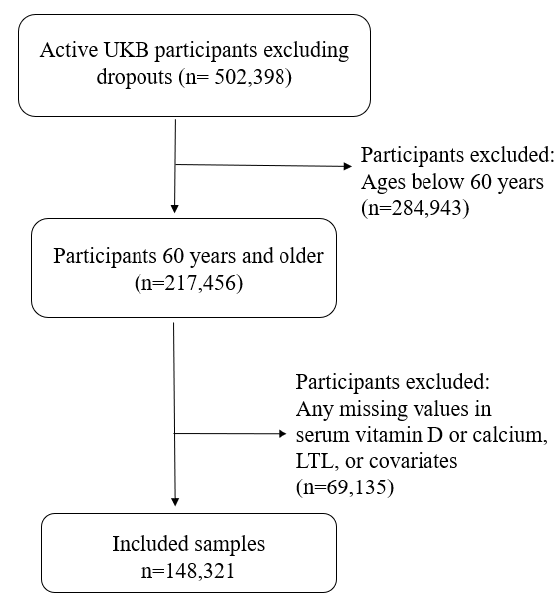
Figure 1. Flowchart of the final analytical Figure 2. Relationship of z ‐ transformed leukocyte telomere length versus z ‐ transformed vitamin D (curve plotted based on the generalized additive model including a cubic regression spline with shrinkage ‐ to ‐ zero). Table 3. Association between vitamin D and leukocyte telomere length, unadjusted and adjusted for covariates. 95% CI